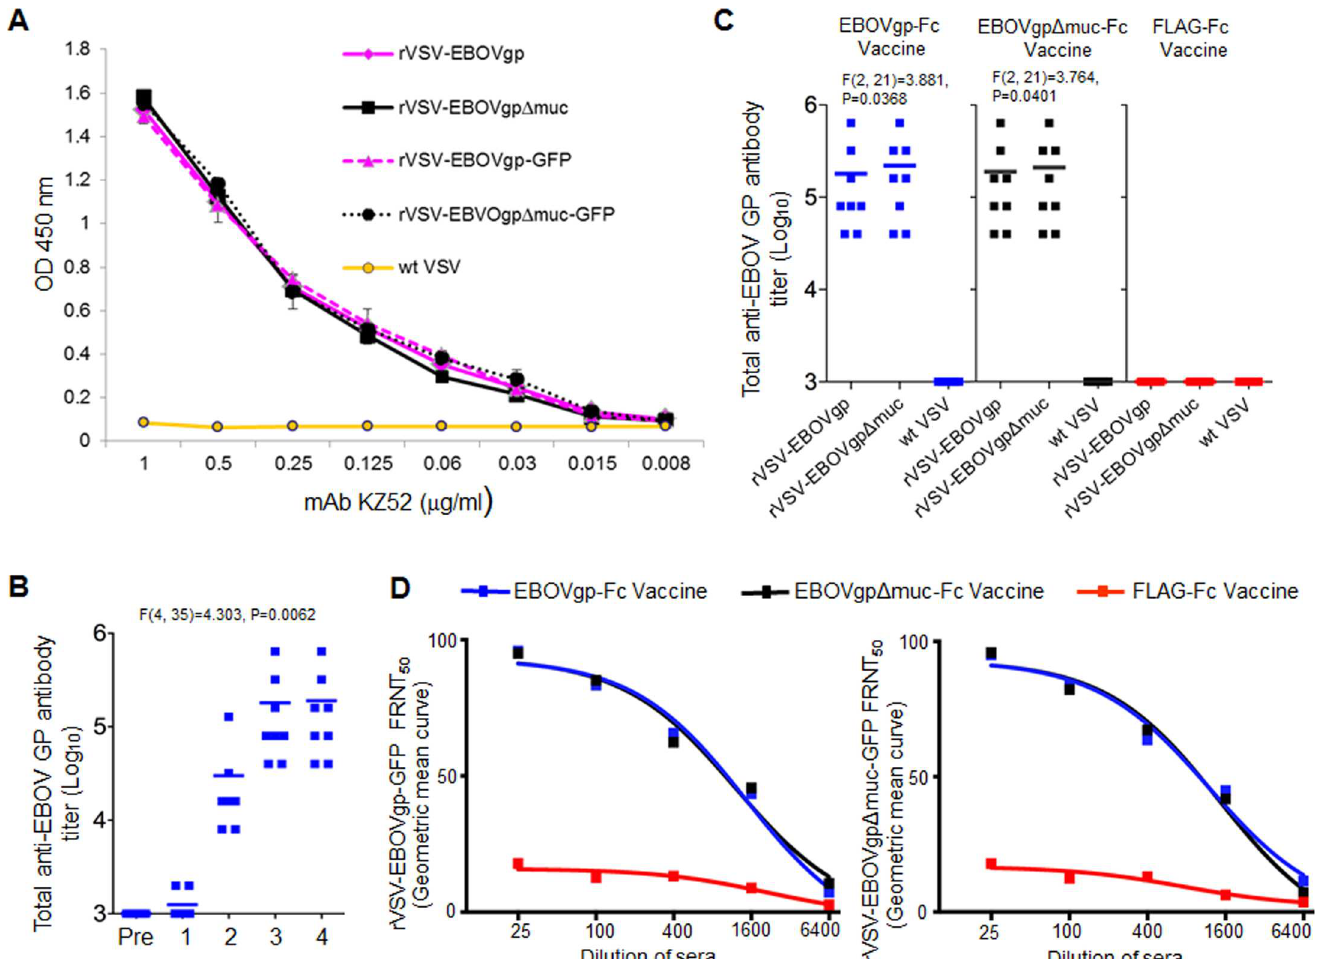
Fig 2. Anti-GPhumoralresponsein strain13 guineapigsvaccinatedwithEBOVgp-Fc or EBOVgp Δ muc-Fc adjuvanted withQS-21. (A) Validation of the particle-to-TCID50ratio and amountof GP incorporated in the virionsused in the ELISA. Similartitersof rVSV-EBOVgp, rVSV-EBOVgp Δ muc, rVSV-EBOVgp-GFP, rVSV-EBOVgp Δ muc-GFP, and negative controlwt VSV were used to coat the 96-well ELISA plate. Human anti-EBOV GP mAb KZ52 was titratedon the plates, and bound antibodieswere stainedwith HRP-labeled anti-humanIgG antibodies.Data are mean absorbance of duplicate wells, and bars representstandarderrorsof mean.(B) Kinetics of anti-GPantibodyproductionin guineapigs (n = 8) vaccinated with EBOVgp-Fc. Serumsampleswere collectedbefore the primaryimmunization (Pre),the 2 nd vaccination at 21 days (1),the 3 rd vaccination at 42 days (2),the 4 th vaccination at 63 days (3),and at 77 days (4).Total anti-GPantibodytiterswere determined by an endpointdilutionvirusparticleELISA in 96-well plates coatedwith rVSV-EBOVgp. (C) Total anti-GPantibodiesin sera fromguineapigs vaccinated with EBOVgp-Fc (n = 8, blue squares), EBOVgp Δ muc-Fc (n = 8, gray squares),or controlFLAG-Fc (n = 7, red squares).Sera sampleswere collectedat day 63 priorto the final (third)boost. Total anti-EBOV GP antibodiesin each animalwere determinedby an endpoint dilutionvirusparticleELISA. The mean for each group of vaccinated guineapigs is shown as a line. Sera fromthe vaccinated guinea pigs were titratedby duplicateson 96-well plates coatedwith rVSV-EBOVgp, rVSV-EBOVgp Δ muc, and controlwt VSV particles. (D) Analysis of anti-GPneutralizing antibodies by a BSL-2 fluorescence reductionneutralization test (FRNT).rVSV-EBOVgp-GFP (leftpanel)or rVSV-EBOVgp Δ muc-GFP (rightpanel)recombinant viruseswere incubated with four-fold serialdilutionsof sera fromthe vaccinated guineapigs. Vero E6 cell monolayers were infected with these neutralizationreactions,and the numberof GFP fluorescent cells was assessed by flow cytometry 12 h afterinfection. The percentreduction in fluorescent cells comparedto pre-immune serumtreatedviruswas calculatedas the % FRNT. The values are plottedin Geometricmean curveto measureFRNT50titer. Differences in mean antibodytiterswere determinedby ANOVA F-testbetweentime points (B) and groups